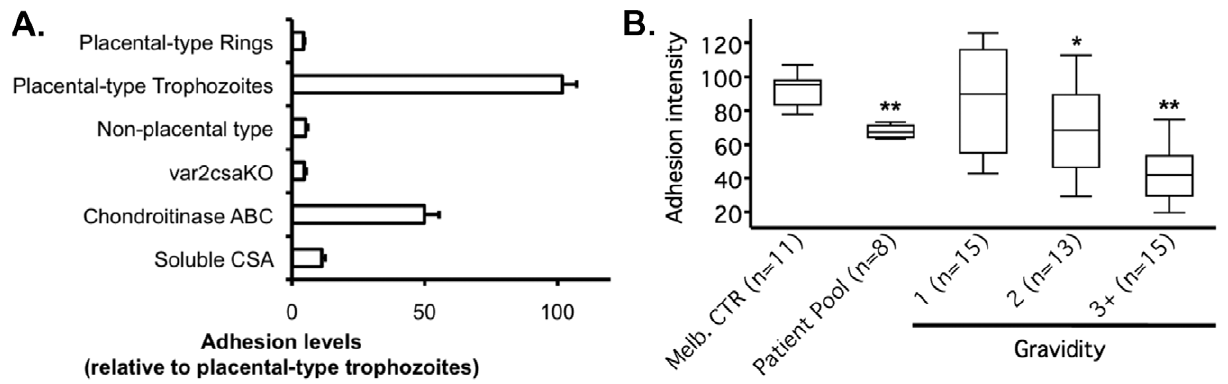
Figure 5. Recapitulation of known characteristics of malaria parasite placental adhesion. ( a. ) When normalized to the adhesion levels of VAR2CSA-expressing, CSA-binding placental-type trophozoites (CS2 line), earlier parasite ring stages show very limited binding. Trophozoites of the non-CSA binding parental line E8B (non-placental type) do not show significant adhesion to vesicles. The inhibition of adhesion of placental-type trophozoites by the disruption of var2csa ( var2csa KO), treatment of vesicles with chondroitinase ABC or pre-incubation of IEs with soluble CSA suggests that most of the adhesion is VAR2CSA/CSA mediated. Data are shown as mean and standard deviation from experimental triplicates. ( b. ) The assay could also detect a parity-dependent adhesion inhibition by sera from malaria-exposed pregnant women. When normalized to the adhesion intensity in the absence of serum, sera from non-pregnant controls from Melbourne (Melb. CTR) did not induce any significant decrease in adhesion intensity whereas a pool of patients’ sera selected for their high immunoglobulin titers against CS2 did. Sera from malaria-exposed pregnant women showed a parity-dependent increase in their adhesion blocking capacity. Boxes show the median, 25 th and 75 th percentiles and whiskers are 5 th and 95 th percentiles from all sera tested in triplicates. *: p=0.046; **: p #